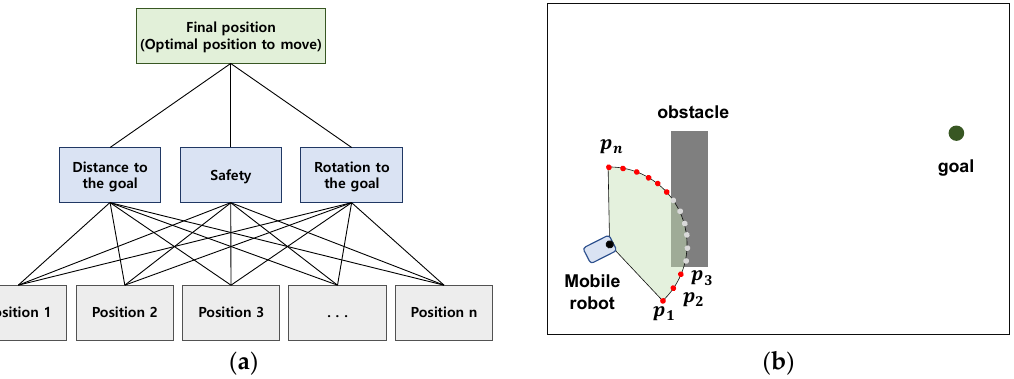
Figure 4. Structure of AHP-based mobile robot path planning: ( a ) AHP structure; ( b ) AHP decision making situation.